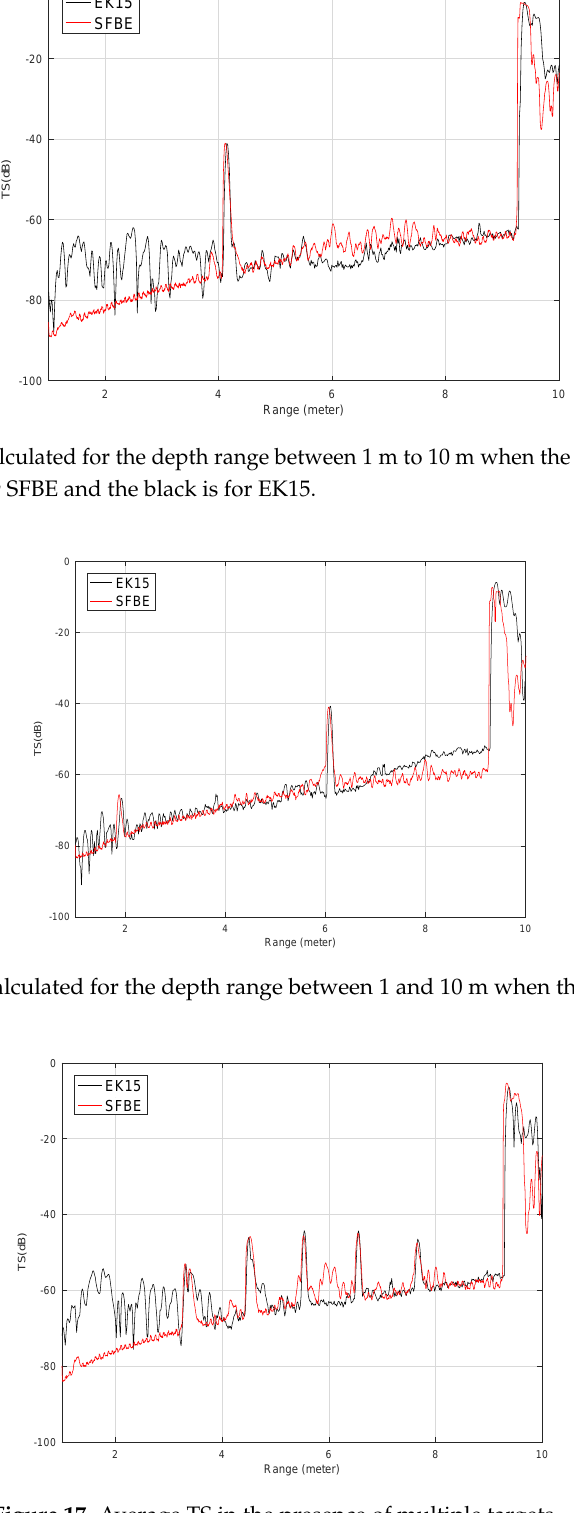
Figure 17. Average TS in the presence of multiple